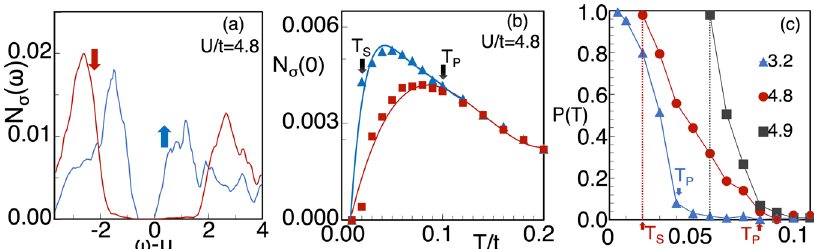
Fig. 2 Thermal evolution of density of states (DOS) & polarization. a This shows the low T density of states, N σ ( ω ) for U / t = 4.8. The large arrows denote the spin channels. b It shows thermal evolution of N σ (0), the spectral weight at the chemical potential for U / t = 4.8. Here triangles denote N ↑ (0) and squares indicate N ↓ (0). The locations of the onset temperature of half metallicity T S and depolarization temperature T P are marked with black arrows. c Shows spin polarization P ( T ) as de fi ned in Section 2 of the main text titled “ Density of states and spin polarization ” , for indicated U values. Various T S and T P are demarcated with arrows color coded with the symbols. Lines are a guide to the eye. All results are shown for b and c are computed from the standard deviation in the spin-resolved DOS, and low-frequency optical conductivity data respectively. Symbol sizes used are larger than the error bars.